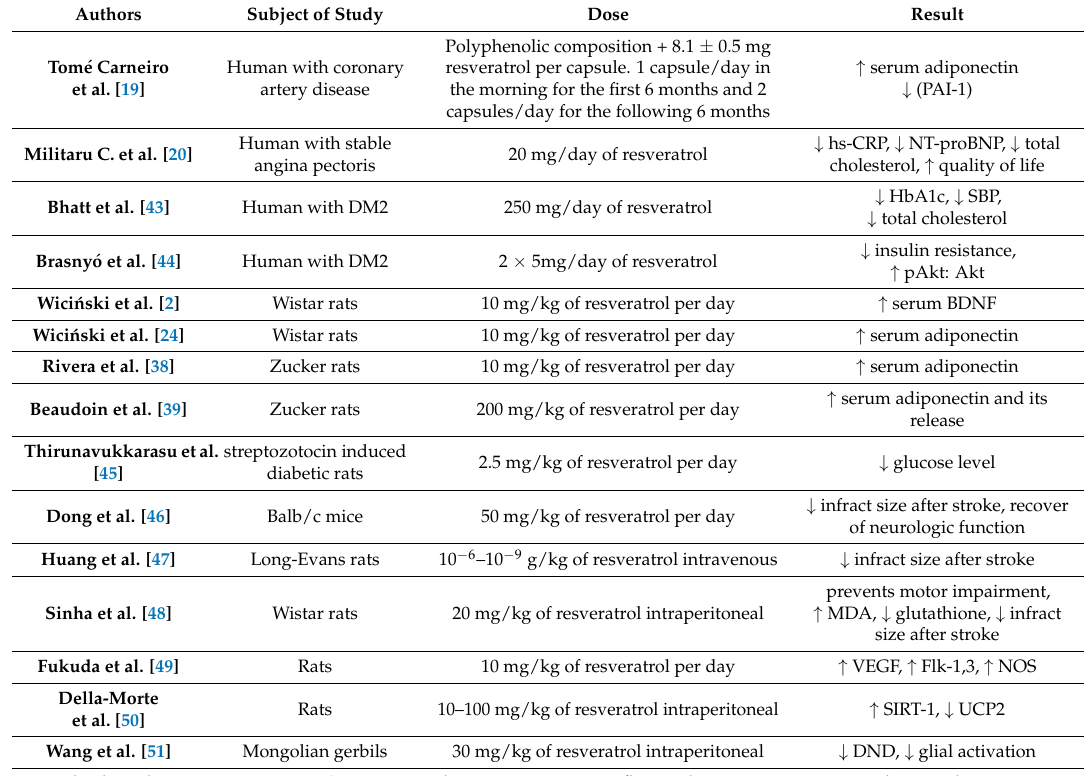
Table 1. Oral administration of resveratrol in vivo